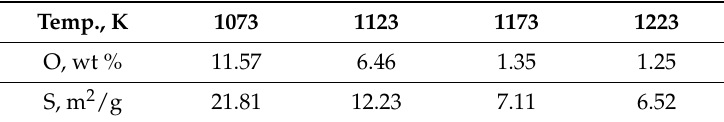
Table 1. Oxygen content (wt %) and specific surface area (m 2 /g) measured in Mg-reduced tantalum powder at different